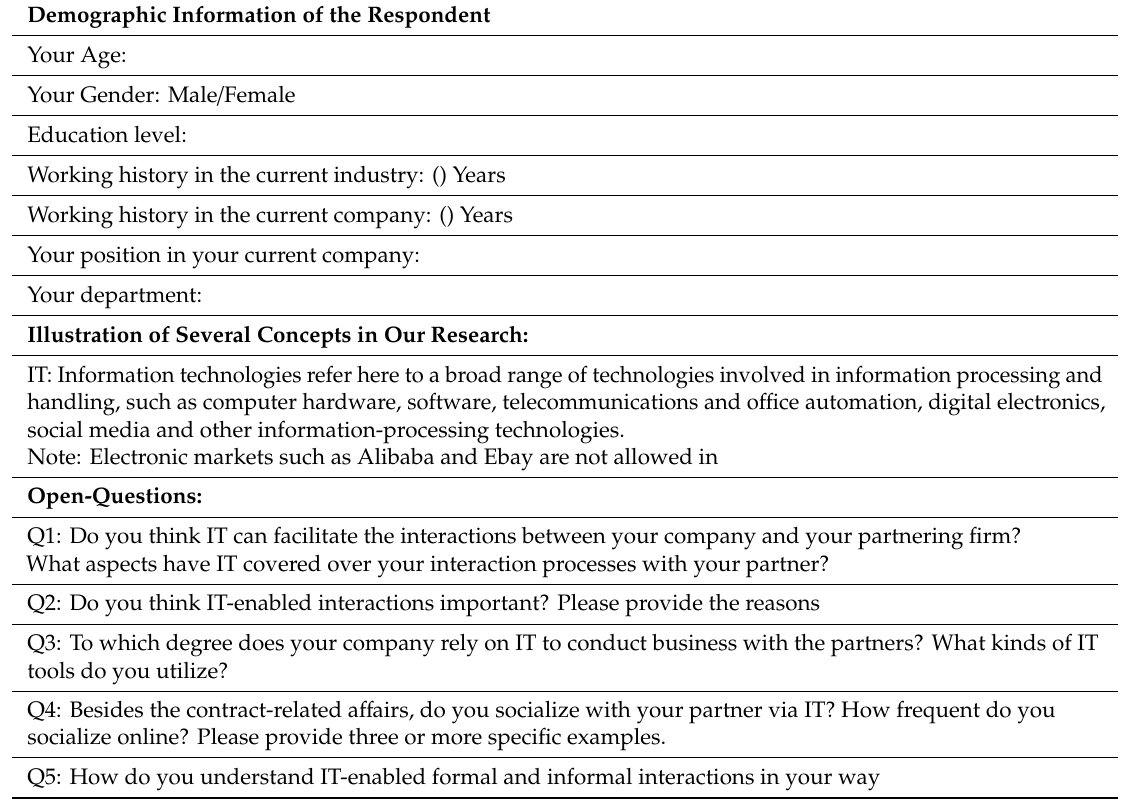
Table 2. The Semi-Structured